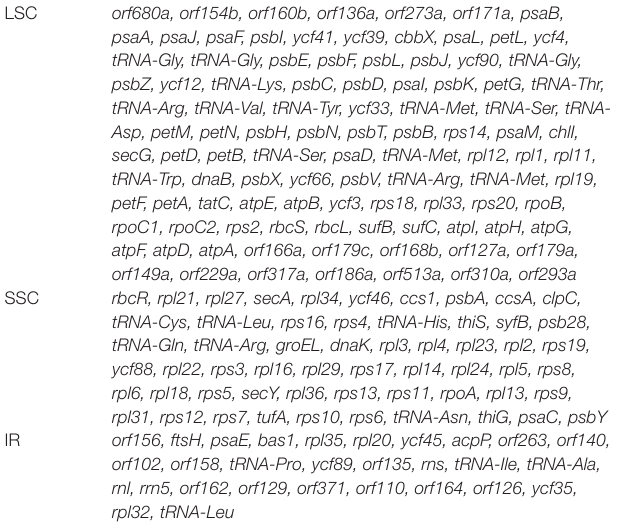
TABLE 2 | Gene composition of the inverted repeat (IR) and single-copy regions (large, LSU; small, SSU) of the Amicula micronesica plastid genome.